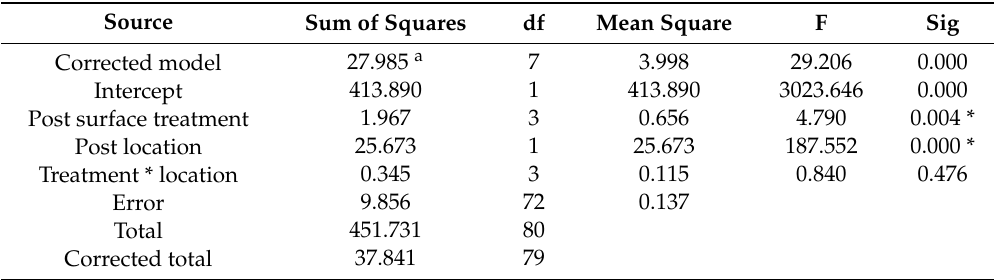
Table 2. Results of a two-way ANOVA with post surface treatment and post location as the independent variables and push-out strength as the dependent variable. Source